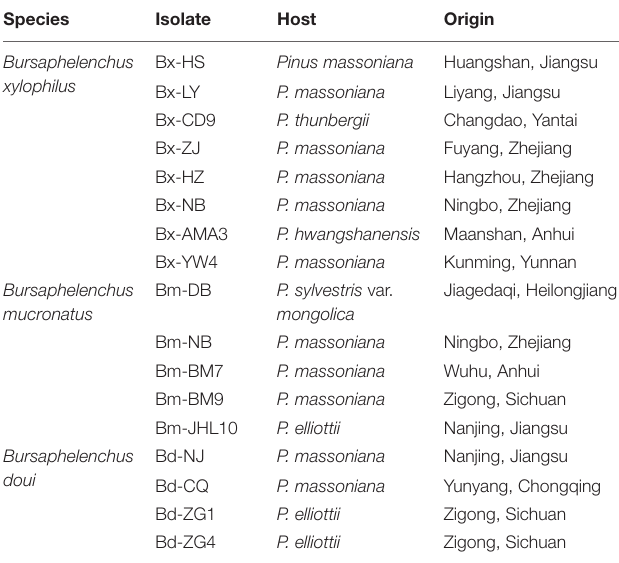
Species Isolate Host Origin Bursaphelenchus xylophilus